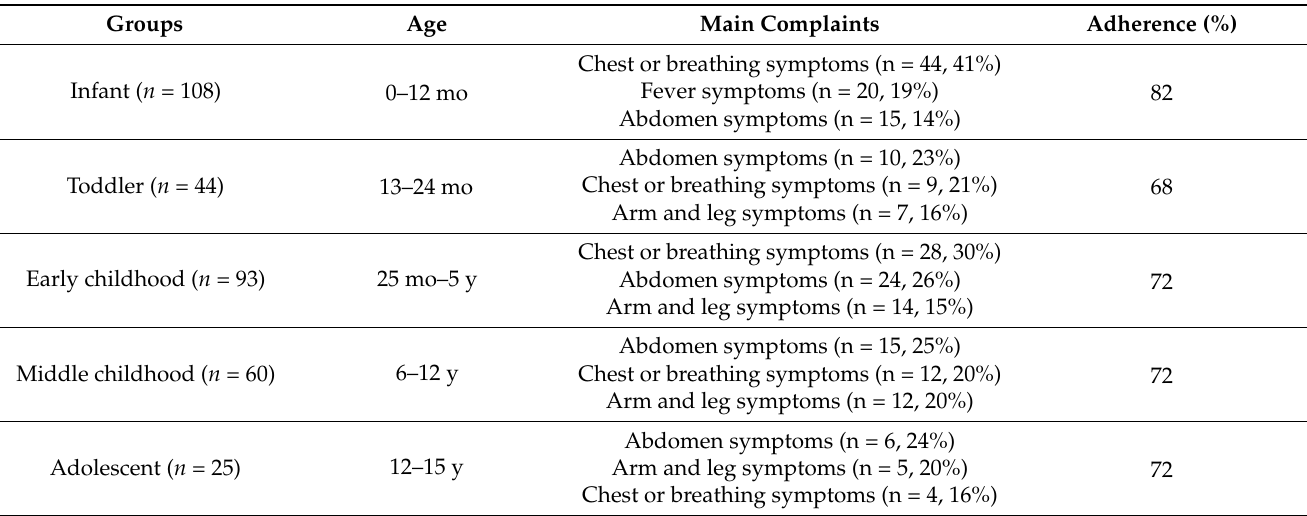
Table 3. Main telephone complaints and adherence rates to the paediatric emergency department referral by age